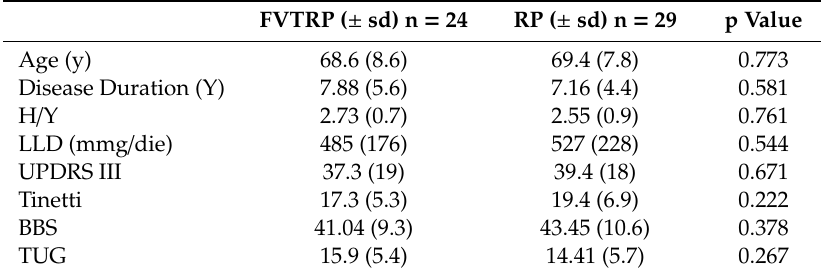
Table 2. Comparison to T0 between the focal vibrations training rehabilitative protocol (FVTRP) and rehabilitative protocol (RP) groups; we used T Student Test for independent samples.